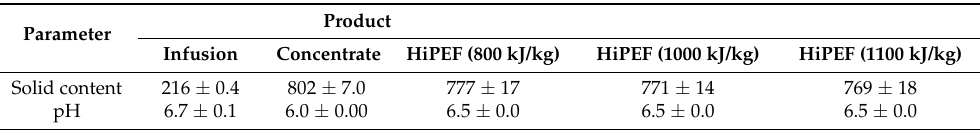
Table 2. Solid content (mg/100 mL of beverages) and pH in infusions and concentrates of Buddleja scordioides treated with high-intensity pulsed electric fields (HiPEF).